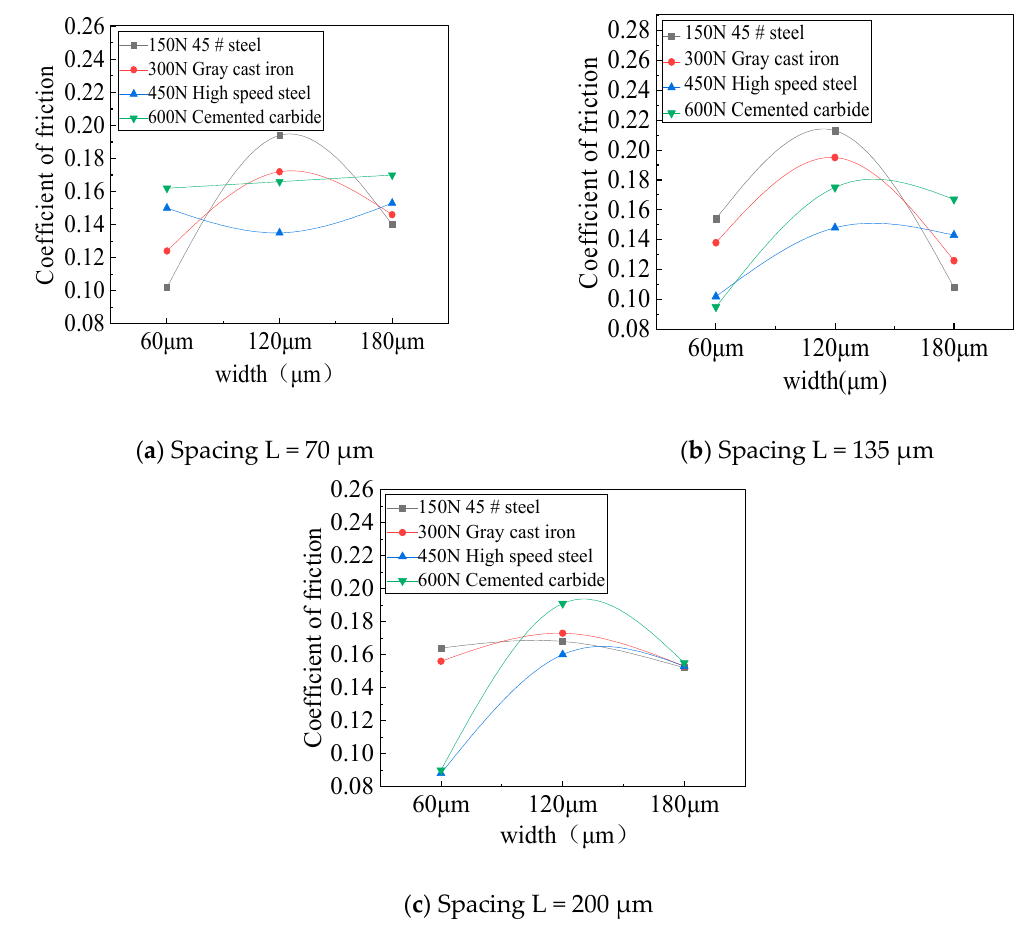
Figure 7. Effect of width on the coefficient of friction under different spacings. Figure 7. E ff ect of width on the coe ffi cient of friction under di ff erent